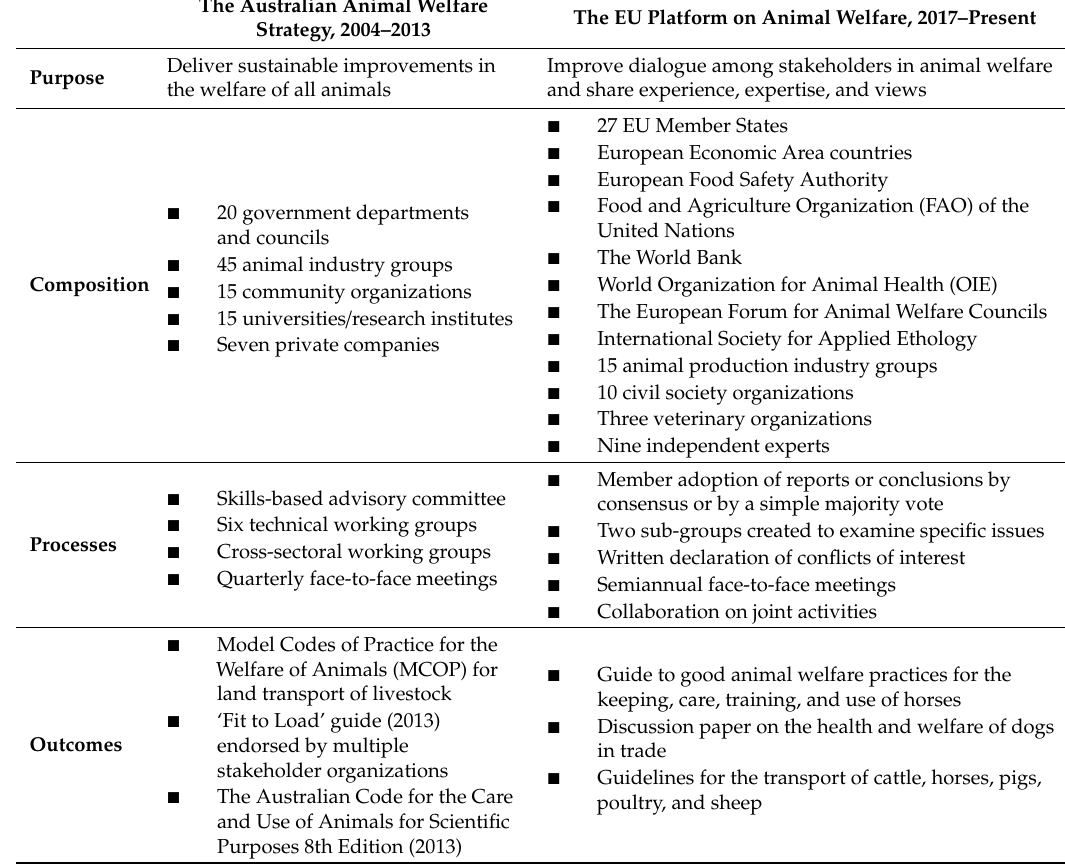
Table 1. Comparison of stakeholder networks in animal welfare. EU: European Union. The Australian Animal Welfare The EU Platform on Animal Welfare, Strategy, 2004–2013